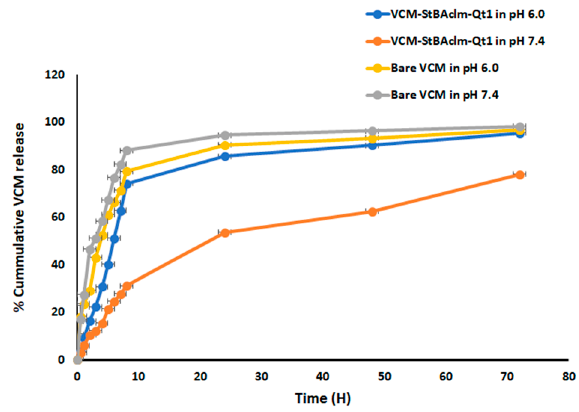
Figure 6. Drug release profiles of bare VCM and VCM-StBAclm-Qt 1 quatsomes at pH 7.4 and pH 6.0. (mean ± SD, n = 3).